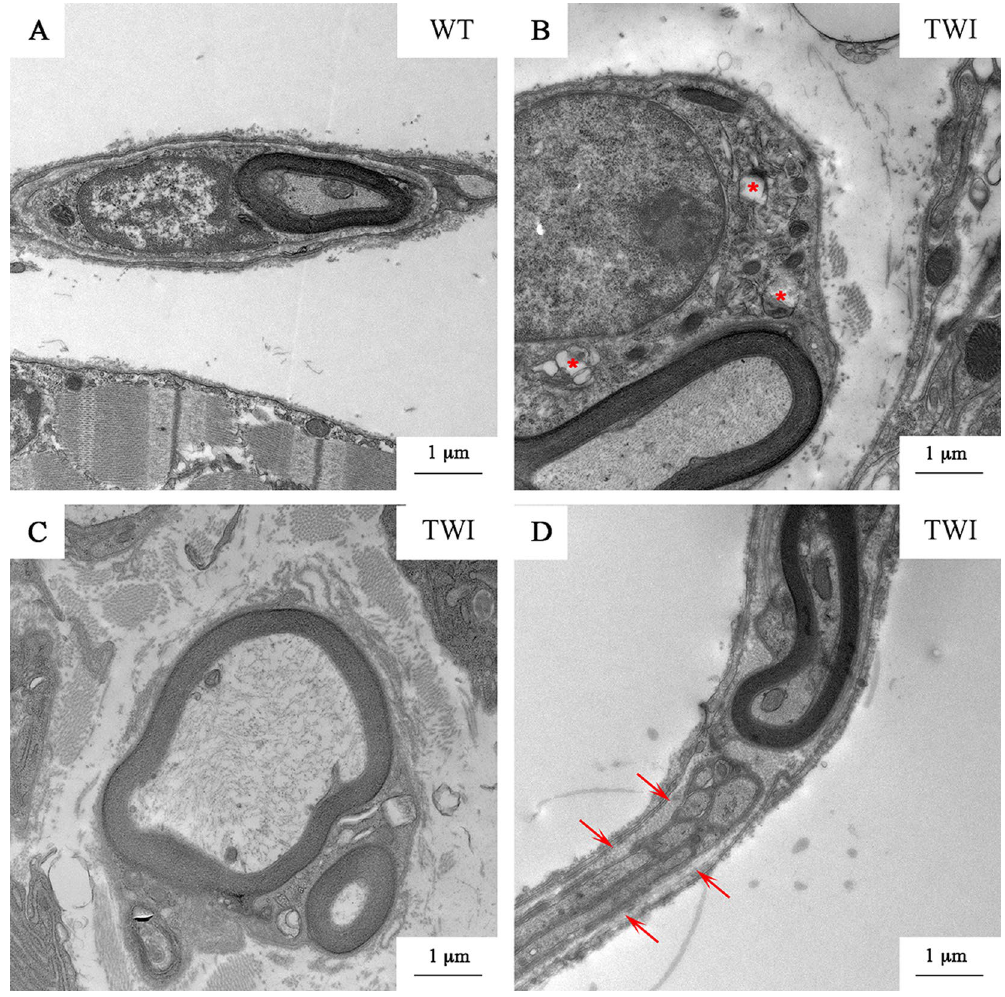
Figure 8. P30 nerve ending: axons and SCs. ( A ) WT nerve ending in gastrocnemius muscle. ( B ) SCs cytosolic compartment is enlarged and some damaged organelles ( * ) are visible; ( C ) MMPs; ( D ) bundles of non- myelinating SCs (arrows) surround myelinated